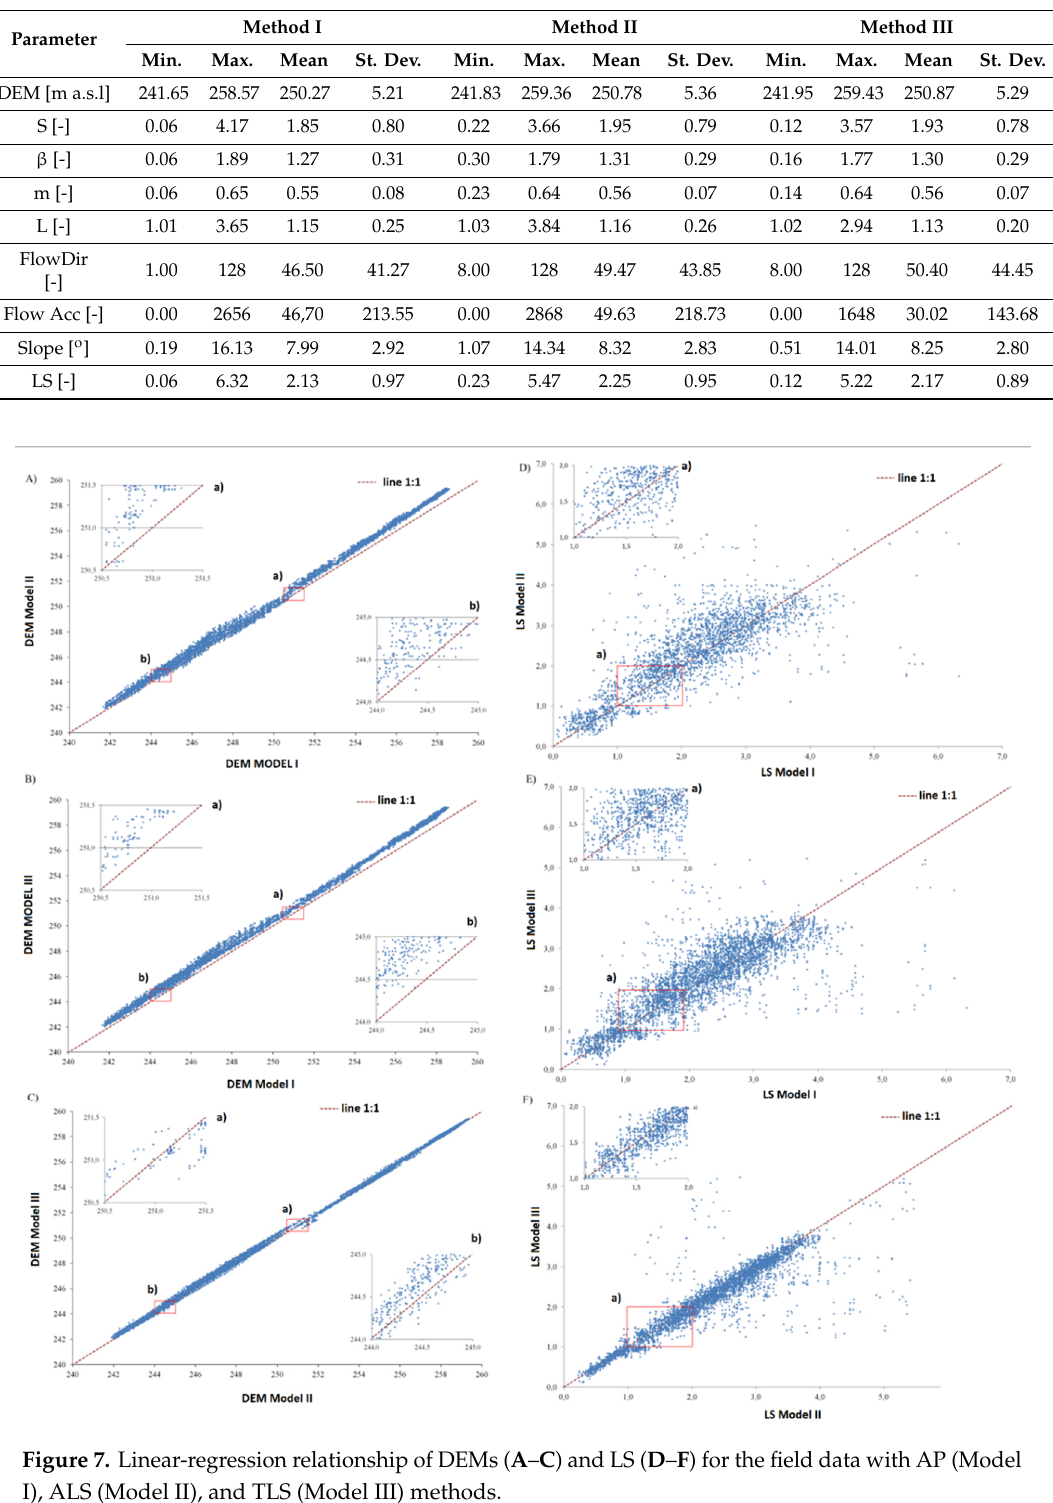
Table 2. Statistics of Model Parameters.